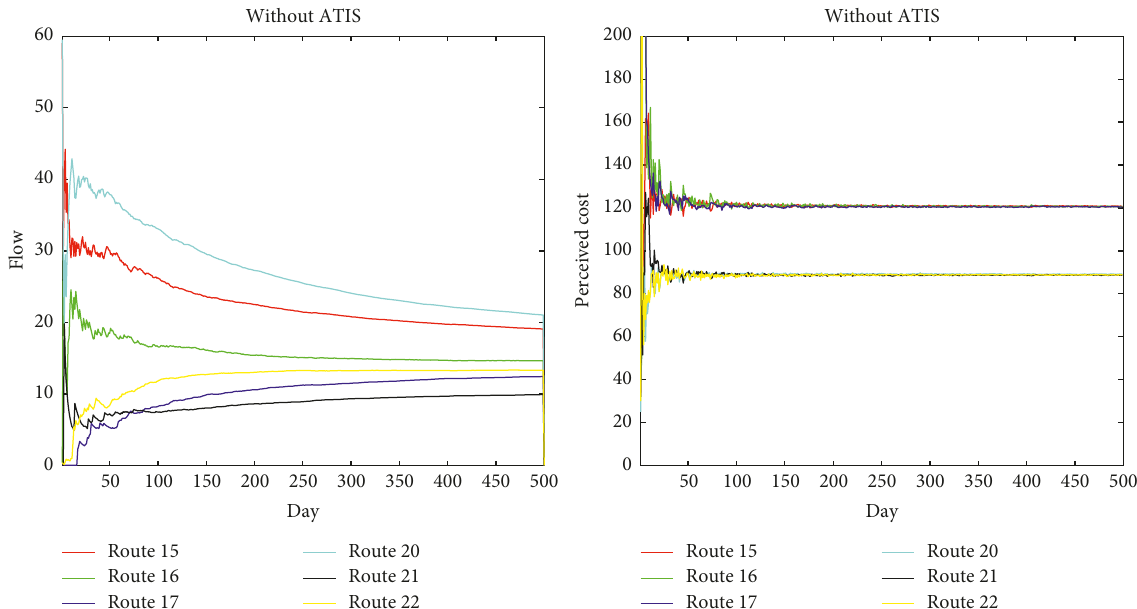
Figure 11: Evolutionary trajectories of route flows (a) and perceived travel costs (b) for travellers in the third